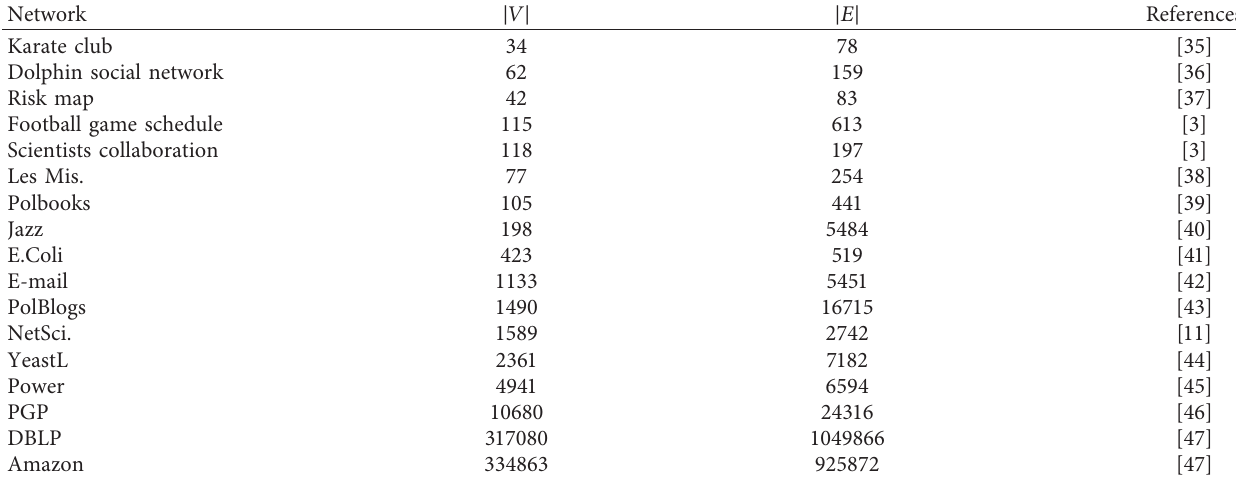
Table 2: The information of real-world networks.